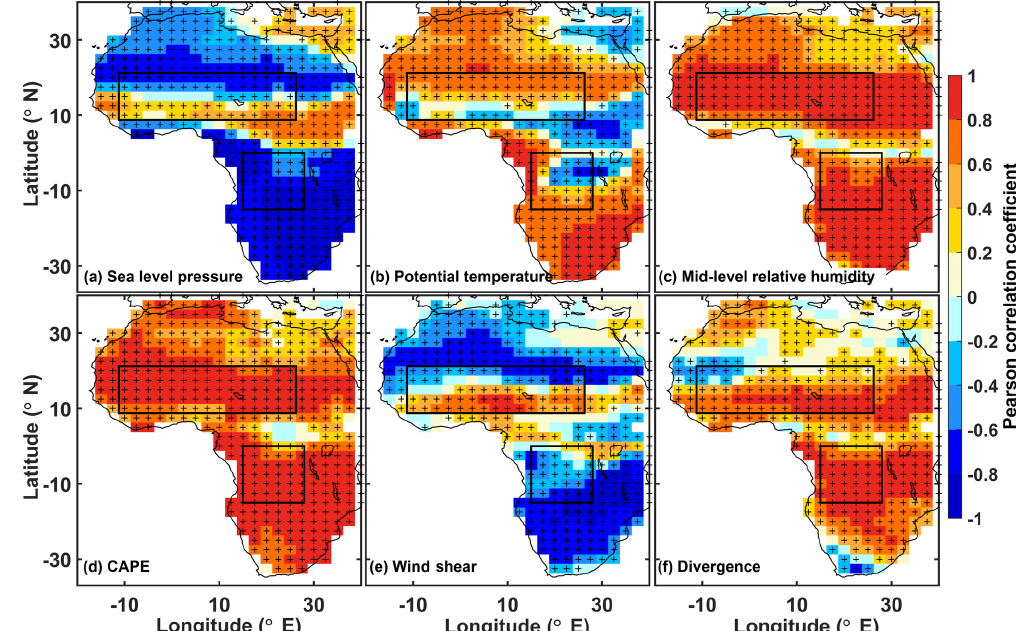
Figure 7. Maps of Pearson correlation coefficients between the lightning flash rate and (a) sea level pressure, (b) potential temperature, (c) mid-level relative humidity, (d) mean convective available potential energy (CAPE), (e) vertical wind shear, and (f) 200hPa divergence over Africa at a spatial resolution of 2.5 ◦ × 2.5 ◦ from 2003 to 2013 (including all seasons). In each grid, 132 samples are used to calculate the correlation coefficient. For each sample, variables are processed using 3-month smoothing averages. The black rectangles outline the dust- and smoke-dominant regions (see Fig. 2, left panel). Plus signs denote those grids that pass the significance test of